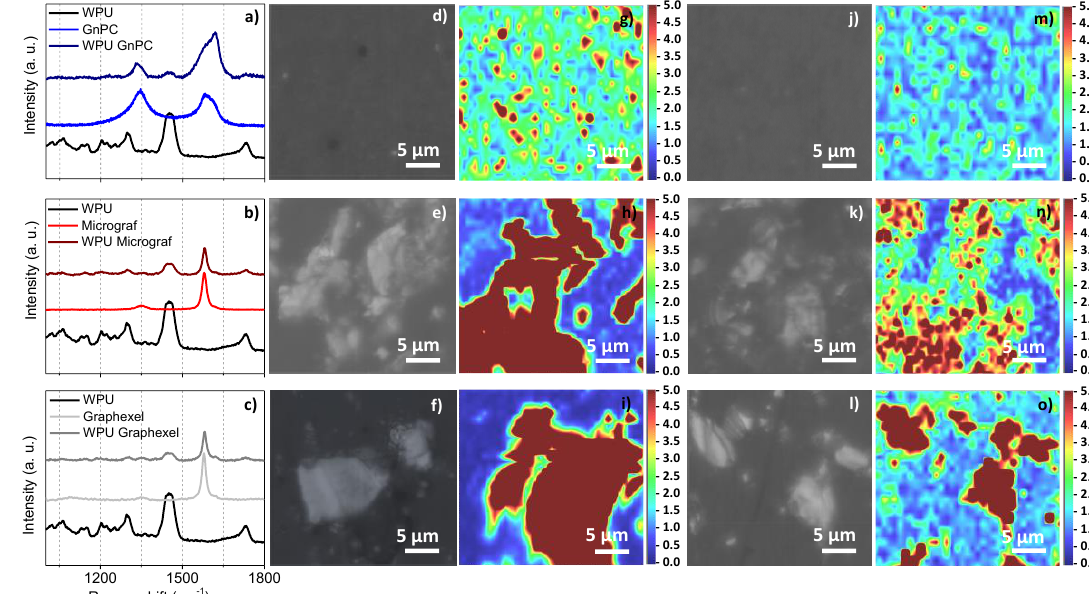
Figure 6. ( a – c ) Representative Raman spectra of WPU, graphitic starting material, and its corresponded WPU composites for GnPC, Micrograf, and Graphexel, respectively; ( d – f ) optical microscopy images and ( g – i ) color-coded Raman mapping for the GnPC, Micrograf, and Graphexel WPU composites at 0.5 wt.%, respectively; ( j – l ) optical microscopy images and ( m – o ) color-coded Raman mapping for the FLG GnPC, FLG Micrograf and FLG Graphexel WPU composites at 0.5 wt.%, respectively.